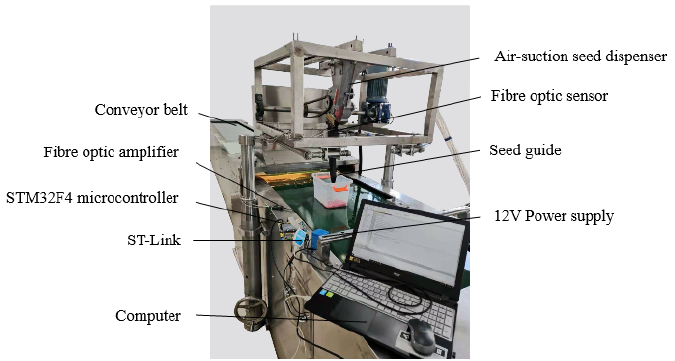
Figure 10. Test site drawing of loss sowing detection system.